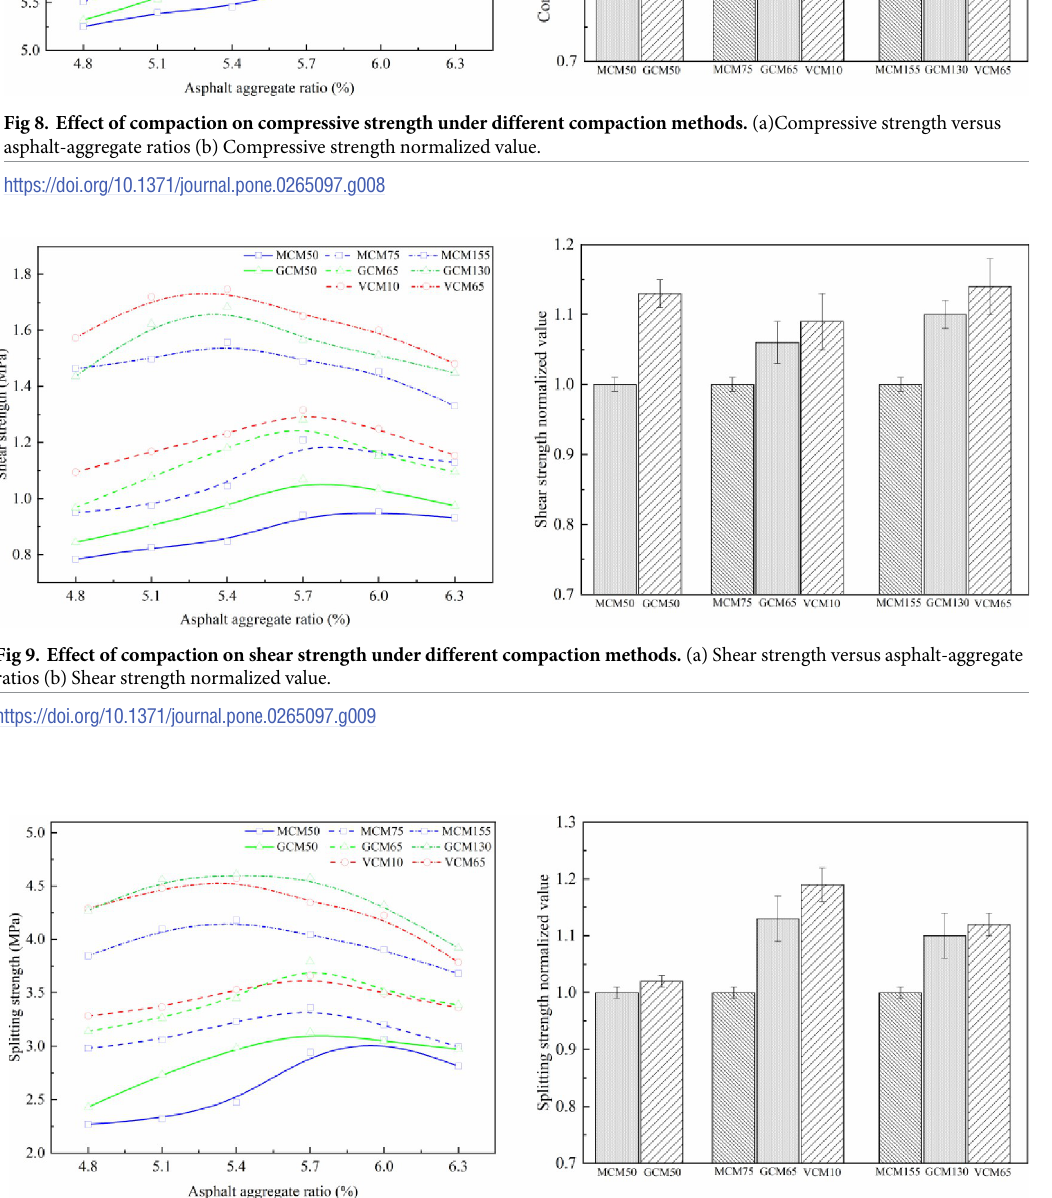
Fig 10. Effect of compaction on splitting strength under different compaction methods. (a) Splitting strength versus asphalt- aggregate ratios. (b) Splitting strength normalized value.